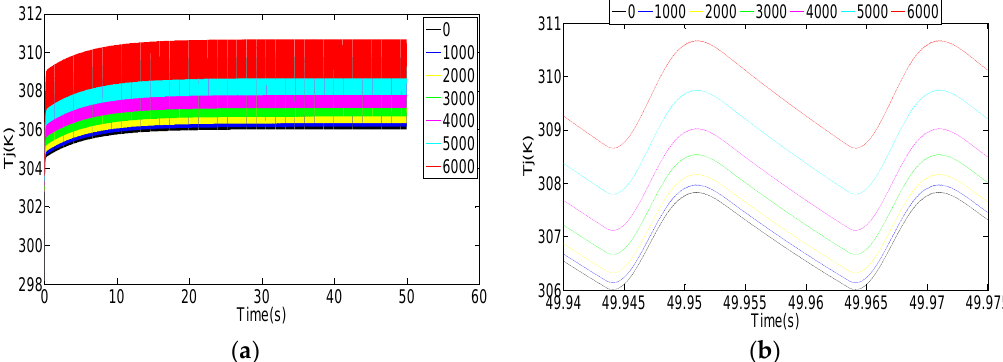
Figure 7. ( a ) The transient junction temperature, ( b ) The steady state junction temperature under different cycle times.